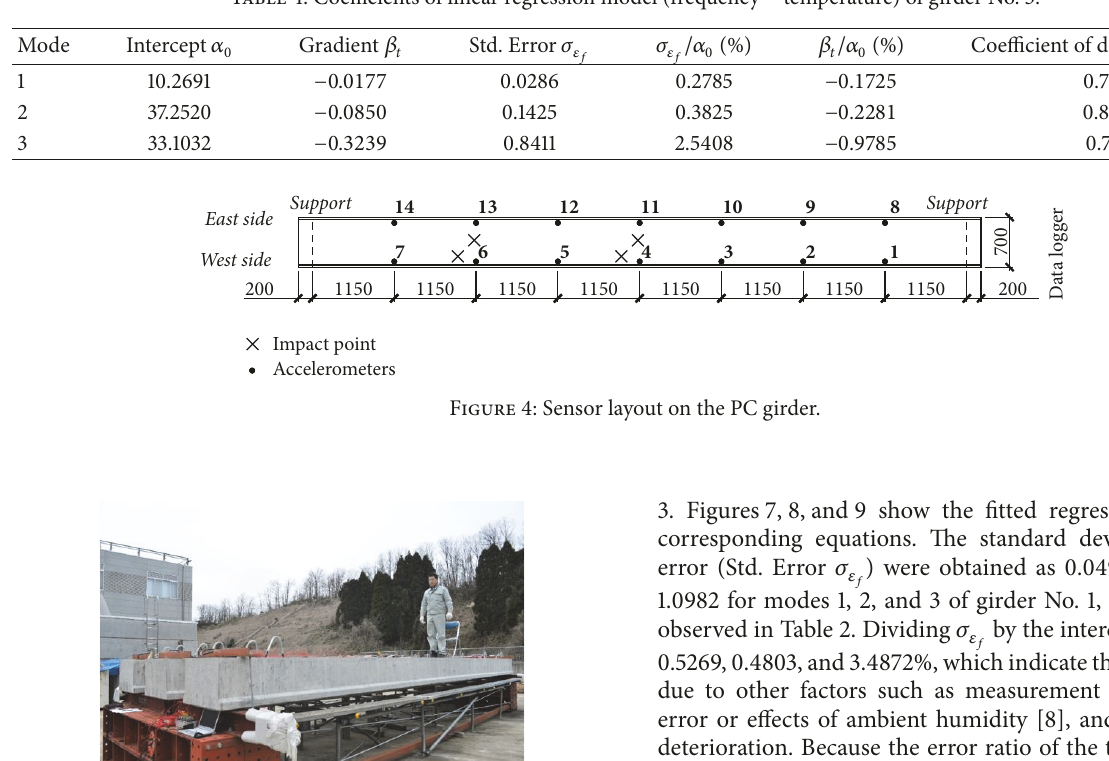
Table 4: Coefficients of linear regression model (frequency ∼ temperature) of girder No. 3.